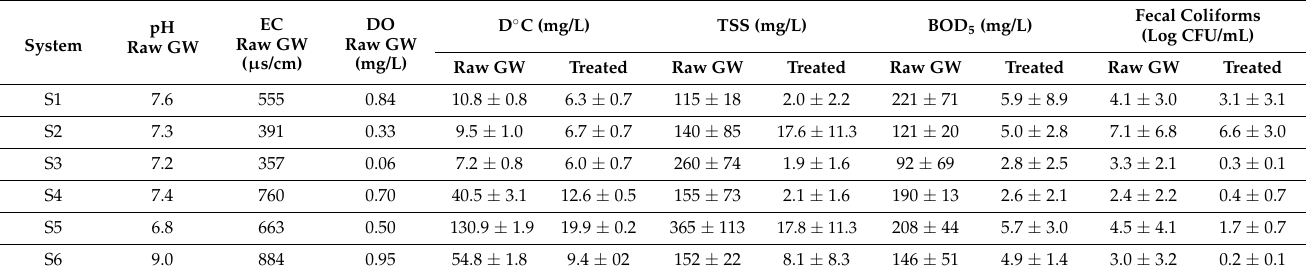
Table 1. Average ± standard deviation of raw and treated greywater quality from the six recirculating vertical flow constructed wetlands. TSS, BOD, and fecal coliform results are based on eight sampling events, twice per season. pH System Raw